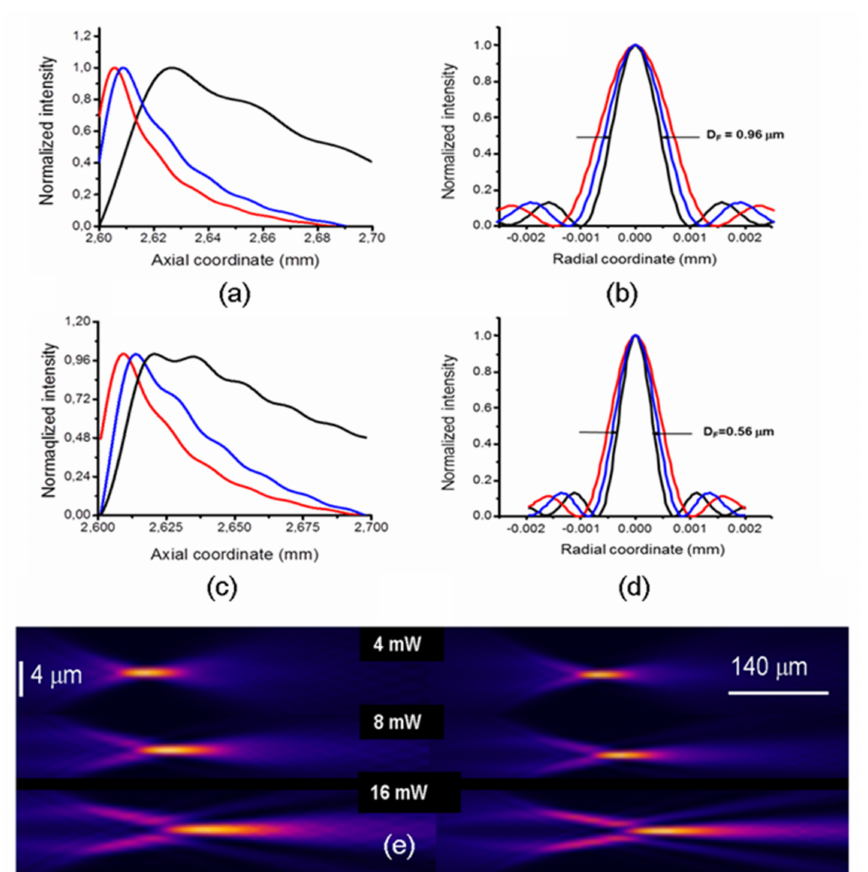
Figure 6. ( a – d ) Theoretical normalized light distributions beyond the focusing optics (focal length, origin of the x-axis = 2.6 mm) for three heating powers P 4 = 4 mW, 8 mW, 16 mW. Upper row ( a , b ): λ 1 = 633 nm; lower row ( c , d ): λ 2 = 405 nm. ( a , c ) Axial and ( b , d ) radial intensities. In ( b , d ), only the radial FWHMs relative to P h = 16 mW are reported. The other parameters are listed in Table 1 for a simpler comparison. ( e ) Computed light intensities for the same heating powers for two wavelengths λ 1 (left side) and λ 2 (right side). The light propagates from left to right. Notice the converging ring on the left of each focal line that evolves in the long range